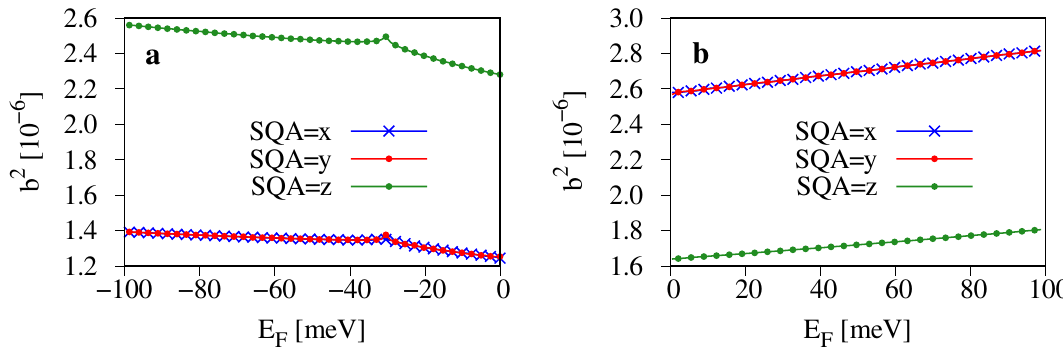
2 versus the position of the Fermi level